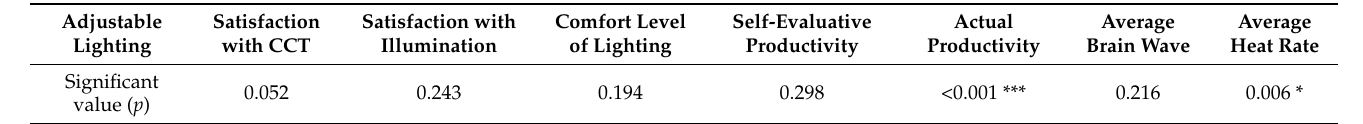
Table 5. Significant ( p ) results of T -test for adjusting lighting in psychological, physiological, and productivity evaluation.